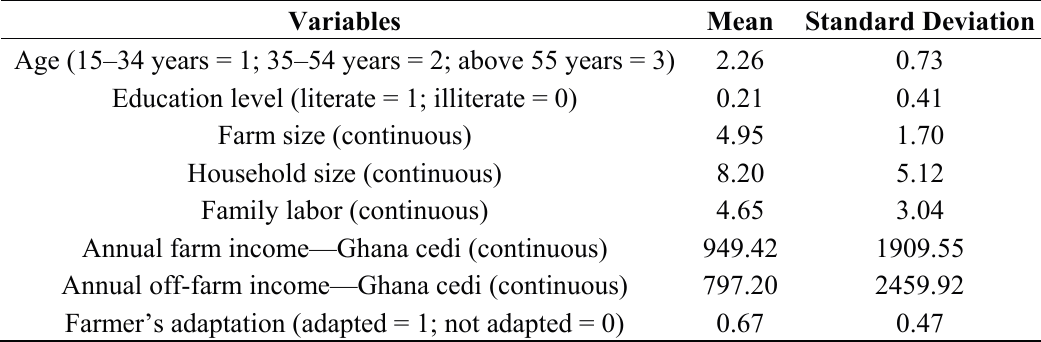
Table 1. Description of data